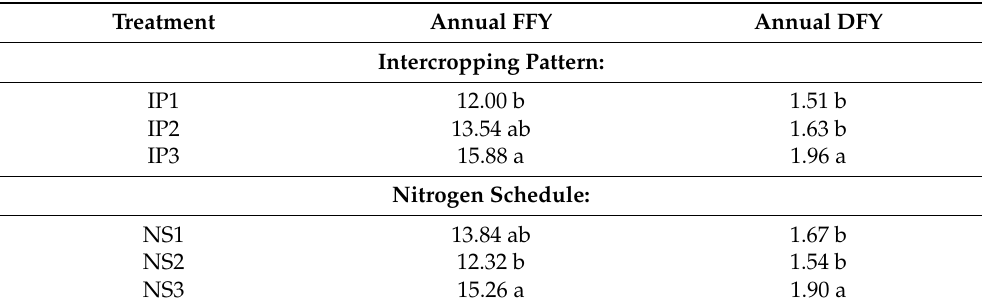
Table 8. Variations of annual fresh and dry forage yields (kg ha − 1 ) of forage cowpea as affected by the intercropping pattern and nitrogen schedule combined over the two growing